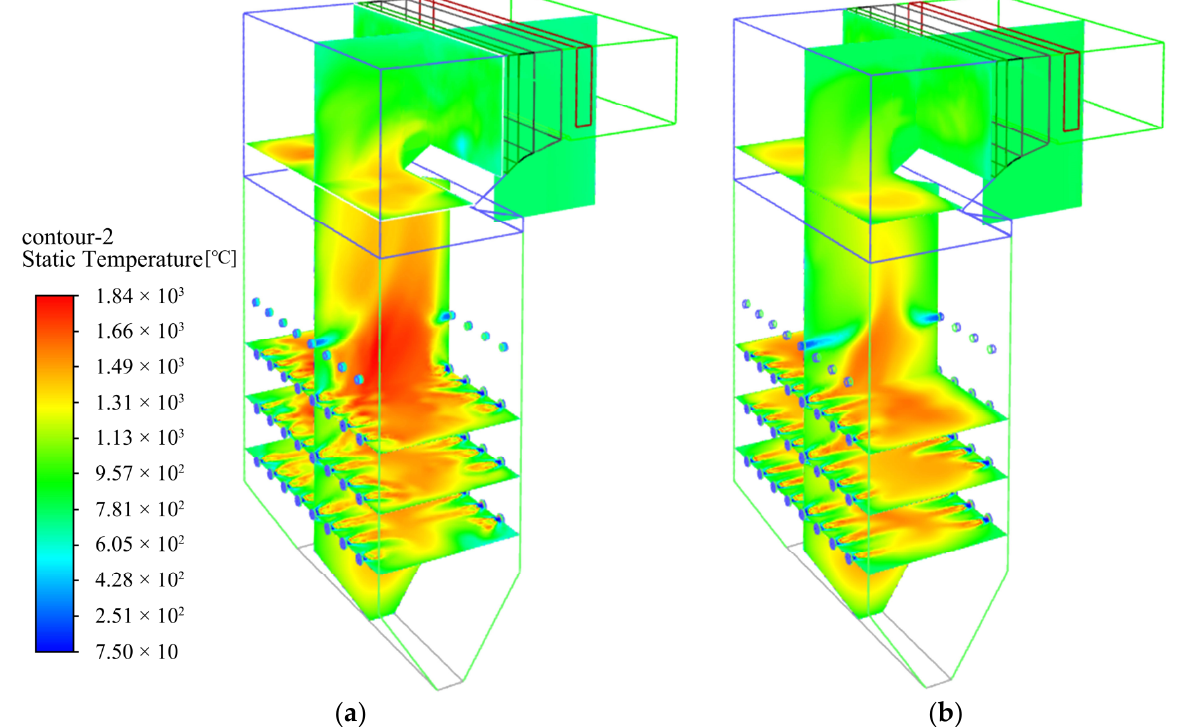
Figure 7. Numerical simulation results of flue gas temperature contours; ( a ) 100% load case; ( b ) 75% load case.